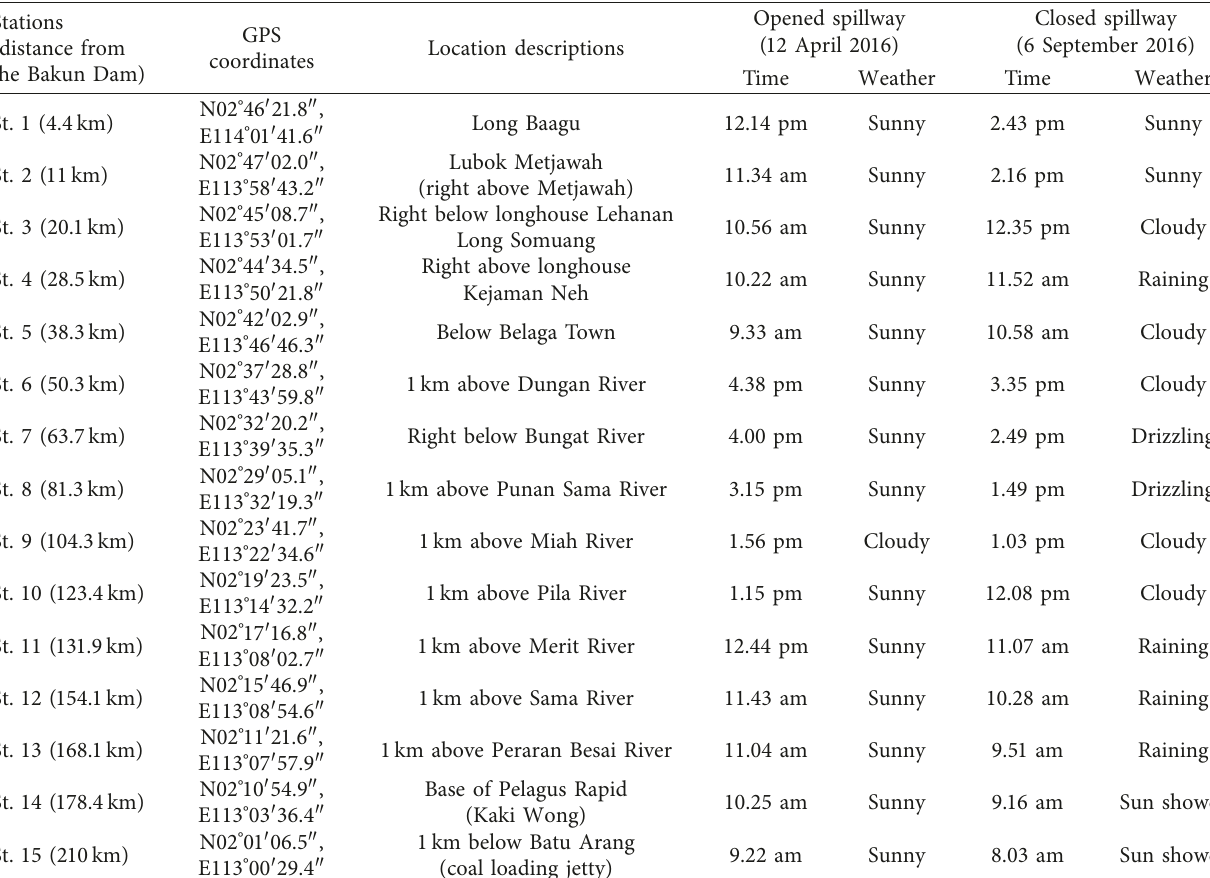
Figure 1: The location of the 15 sampling stations along the Rajang River, below Bakun Dam to Kapit in Sarawak, Table 1: Sampling stations with distance from Bakun Dam, GPS coordinates, location description, time, and weather conditions during opened and closed spillways.